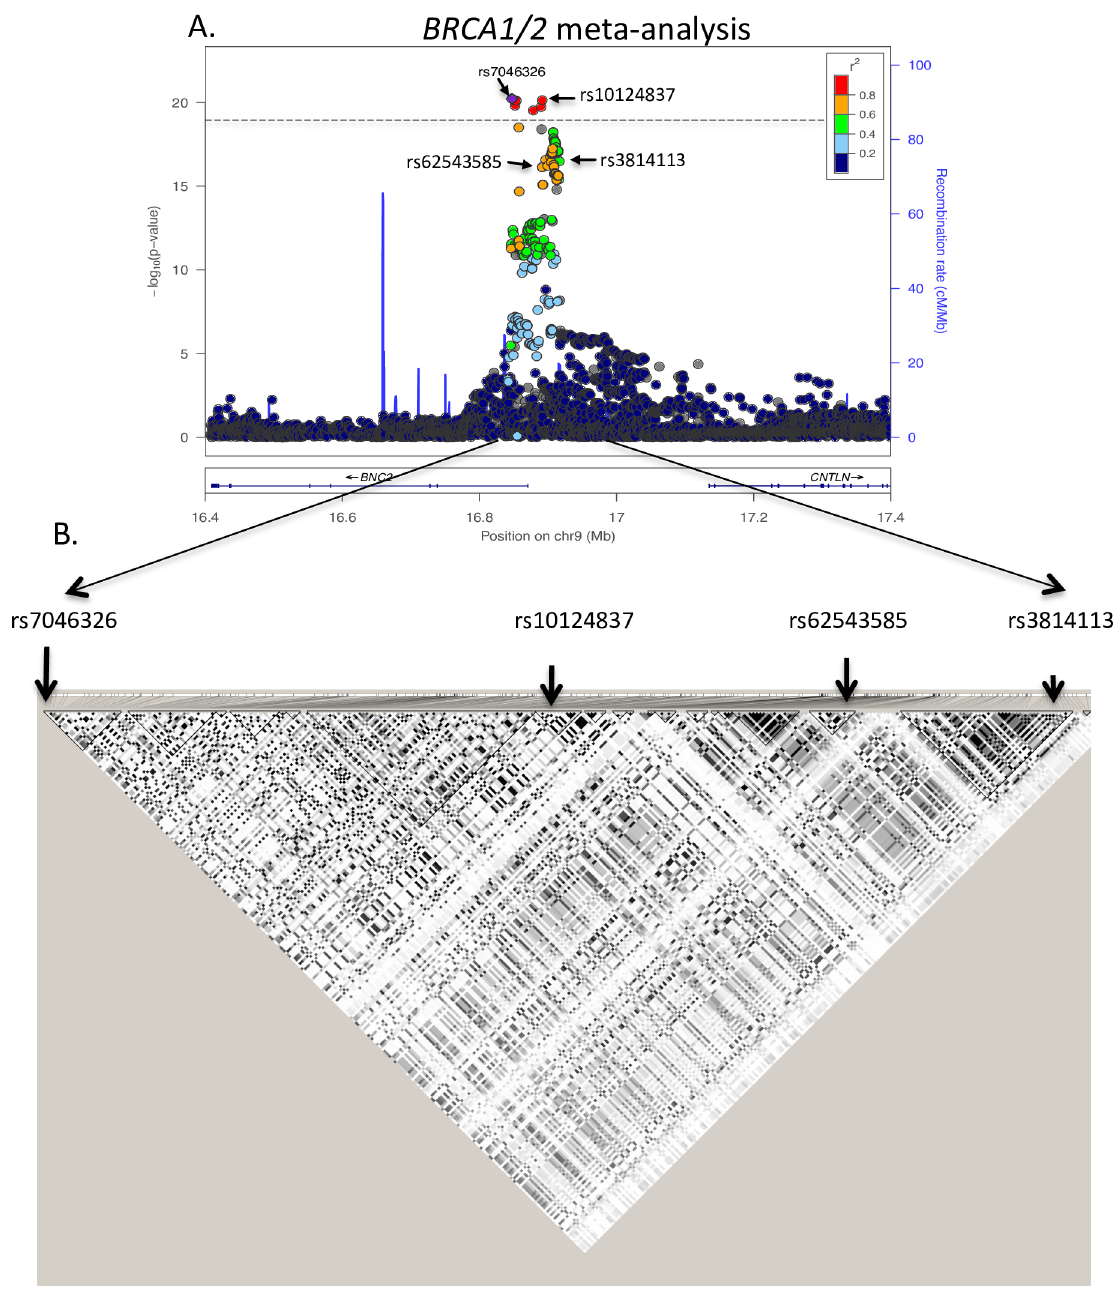
Fig 2. Associations between SNPs in 9p22.2 with ovarian cancer risk for the meta-analysis of BRCA1 and BRCA2 mutation carriers. (A) The purple diamond corresponds to the strongest associated SNP and the colour code indicates the linkage disequilibrium with respect to this variant. Horizontal lines indicate the -log 10 p-value such that the SNPs above the line are the potential causal ones. This set was defined based on a likelihood ratio for a particular SNP as being less or equal than 100, relative to the most likely variant and r 2 > 0.1. (B) Haplotype block indicating relevant SNPs. From left to right the indicated SNPs correspond to: the strongest associated in BRCA1/2 meta-analysis, the strongest in BRCA1 and the strongest in BRCA2